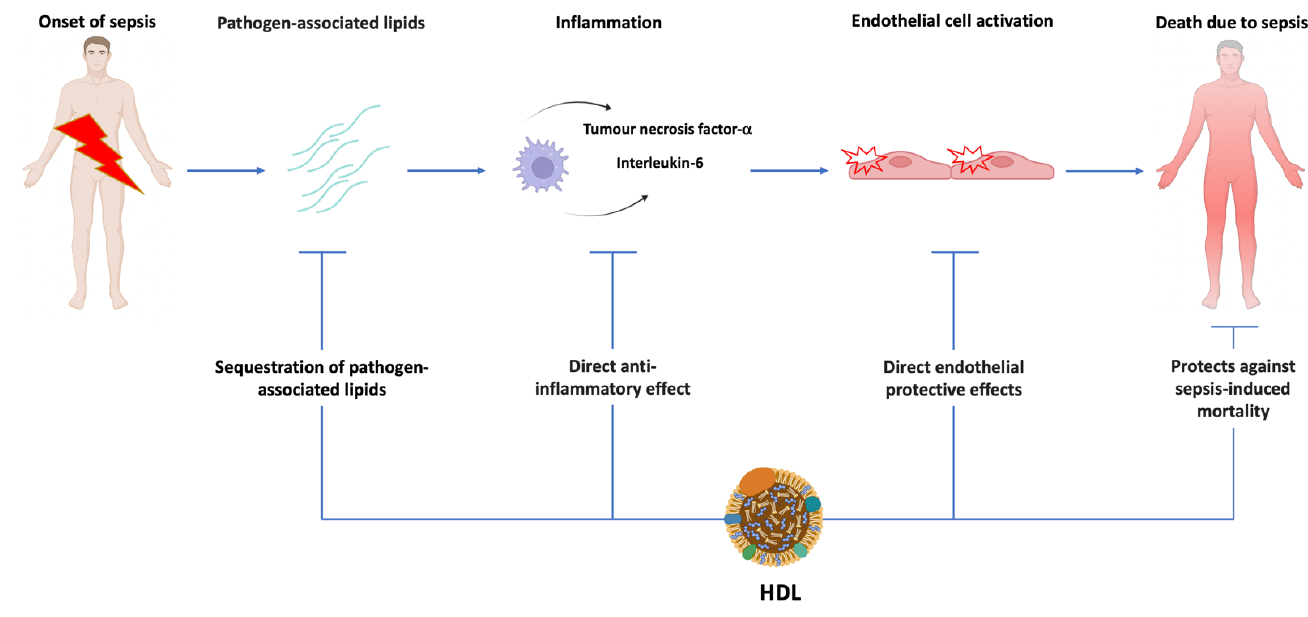
Figure 1. General overview of the mechanisms that contribute to the protective effects of HDL in sepsis. HDL have the potential of sequestration and neutralization of pathogen-associated lipids, exert direct anti-inflammatory effects, and can also counteract activation of the endothelium induced by cytokines. Increased HDL cholesterol predicts a lower mortality in patients with sepsis.